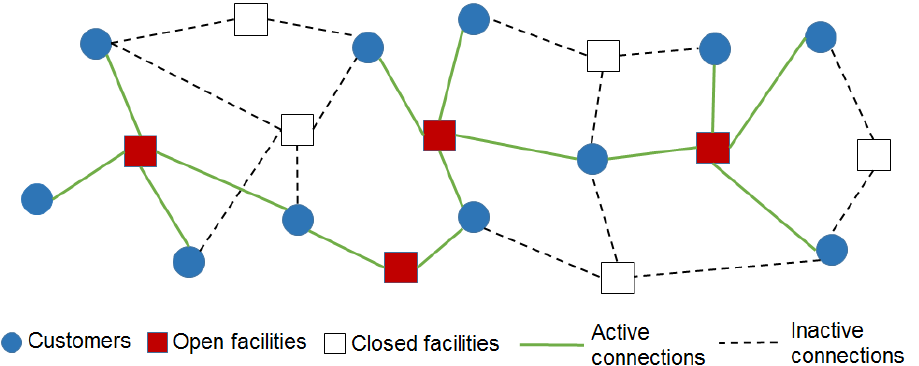
Figure 2. Illustrative example of the classical FLP based on the work in